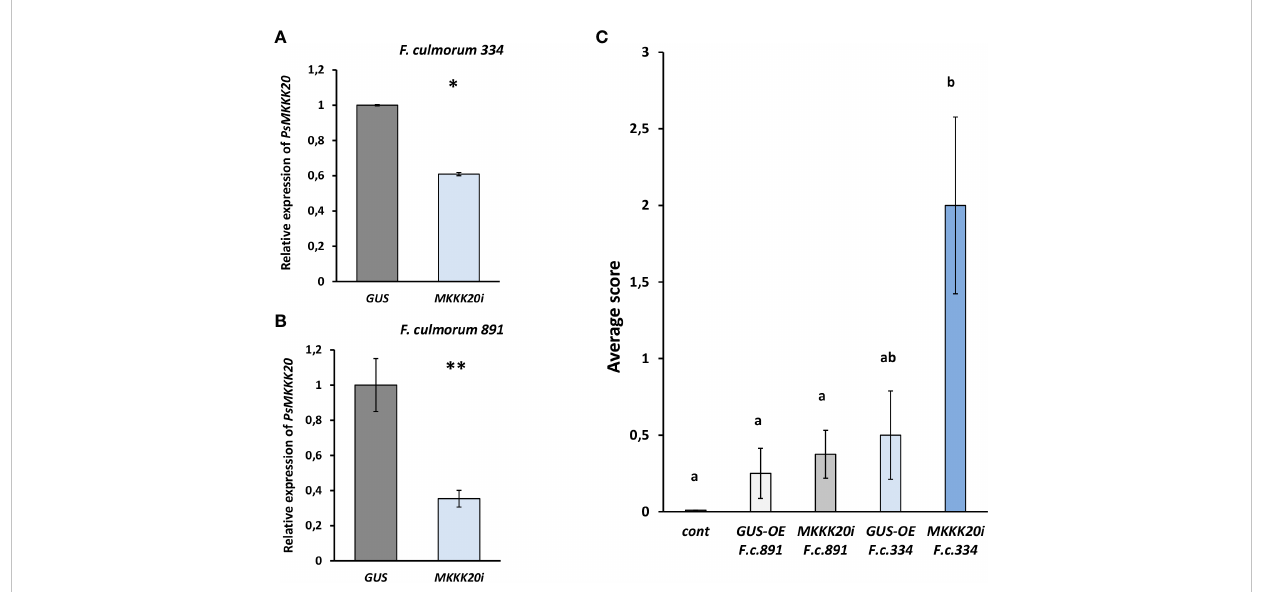
FIGURE 9 The effect of PsMAPKKK20 gene suppression on resistance to the pathogenic fungus Fusarium culmorum highly aggressive 334 (A) and weakly aggressive 891 strains (B) in Pisum sativum cv. Finale plants. Composite plants with the PsMAPKKK20 gene suppression in transgenic roots ( PsMAPKKK20-RNAi ) were compared with control plants with b -glucuronidase gene overexpression ( GUS-OE ). Analysis was performed two weeks after infection with F. culmorum . Approximately 50 - 60% suppression of the PsMAPKKK20 gene in the transgenic roots of pea was revealed (A, B) . One-way ANOVA test was used to compare gene expression levels. The resistance to infection in transgenic roots of PsMAPKKK20 -RNAi plants was signi fi cantly reduced in comparison to GUS-OE control (C) . Two biological replicates were analyzed for P. sativum , each containing 10 – 15 plants per variant. Totally about 40 and 30 transgenic fl uorescent roots of PsMAPKKK20 -RNAi and GUS-OE plants, correspondingly, were included in the analysis. Kruskal-Wallis test (R-studio) was used to compare infection scores in PsMAPKKK20 -RNAi and GUS-OE variants. Values are means ± SEM. *, values with various letters are signi fi cantly different at P < 0.05; **, signi fi cant difference at P <